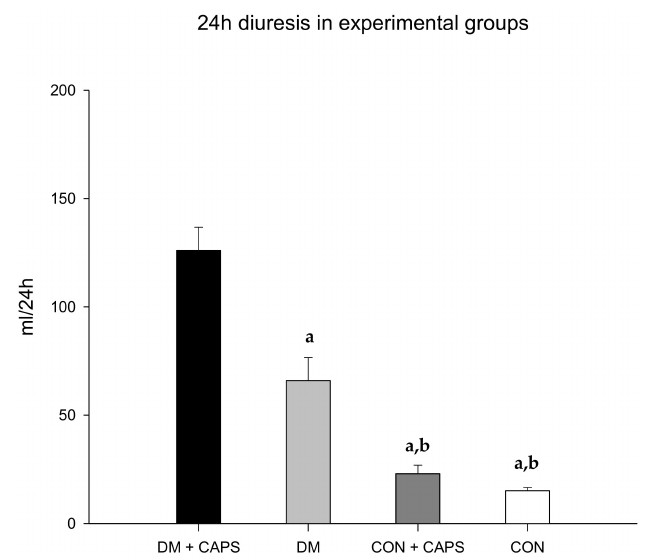
Figure 1. Effect of 8 weeks of capsaicin administration (1 mg/kg/day) on diuresis. ( a ) Statistically significant difference in comparison with the DM group + CAPS; ( b ) statistically significant difference in comparison with the DM group. Data are mean ± SEM. Table 2. Two-way ANOVA analysis of the effects of DM, CAPS and their interaction on parameters related to early stages of kidney